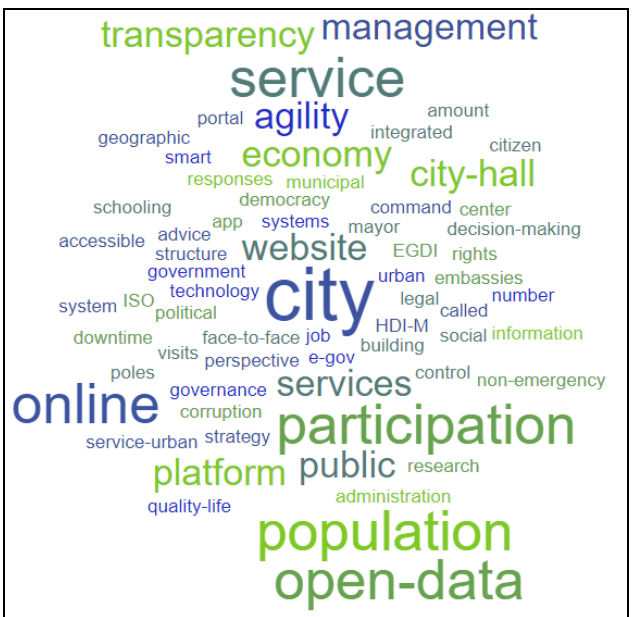
Figure 19. Most frequent indicators within the theme of “governance”.